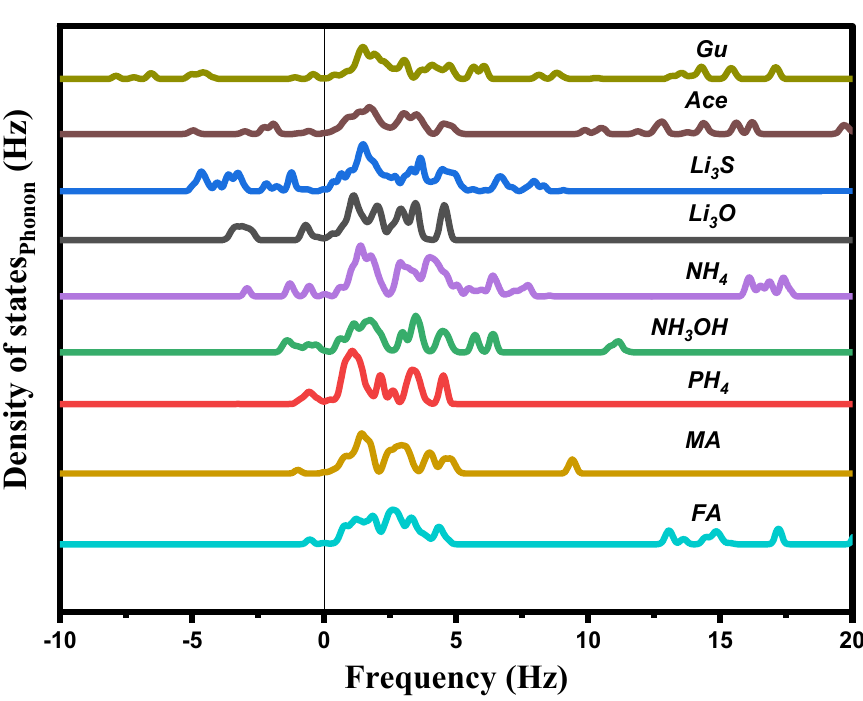
Figure 4. Calculated total phonon density of states Ph − DOS for A i PbI 3 with the different substituting cations.